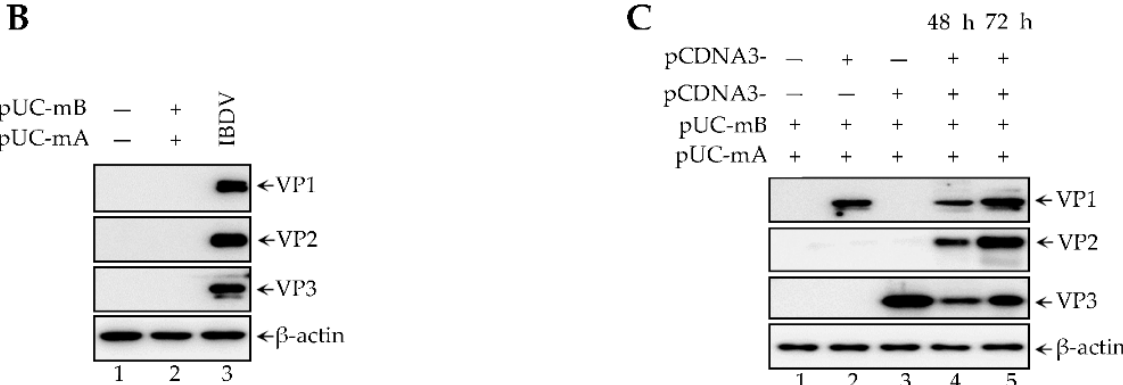
Figure 1. Polymerase I promoter transcripts minus-sense genome of IBDV. ( A ) Full length of mi- nus-segment A/B were sub-cloned into the backbone of a pUC57 vector between Polymerase I Pro- moter and Terminator I, named as pUC57-mA and pUC57-mB. ( B ) 293T cells transfected with both pUC57-mA and pUC57-mB or infected with 1 MOI IBDV. The cell lysates were subjected to western blot using antibodies against viral protein VP1, VP2, and VP3. ( C ) Indicated plasmids were co-trans- fected into 293T cells at 48 h and 72 h. The cell lysates were subjected to western blot for detecting viral protein VP1, VP2, and VP3.